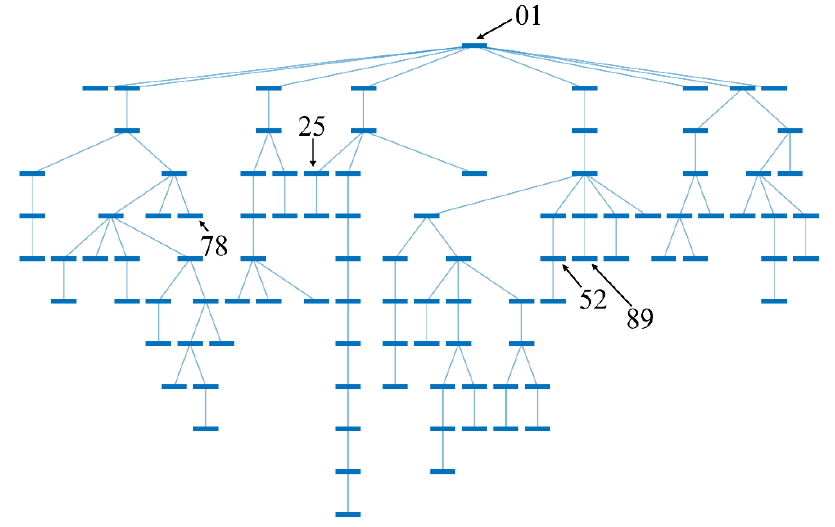
Figure 1. Simulated network topology.